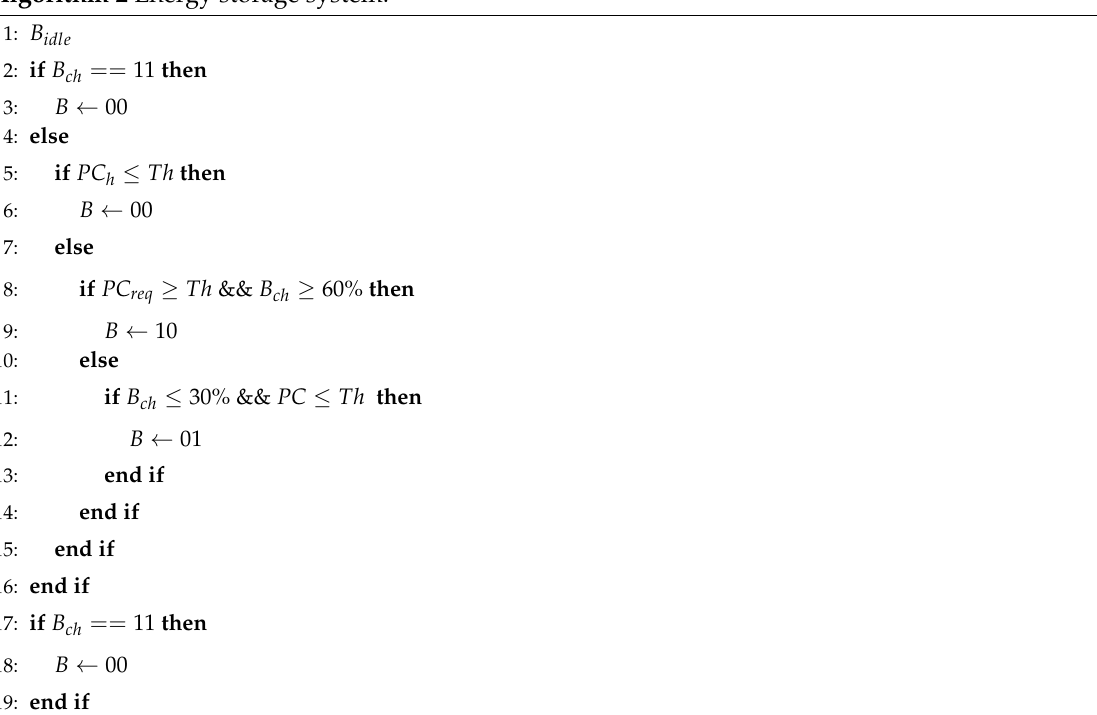
Algorithm 2 Energy storage